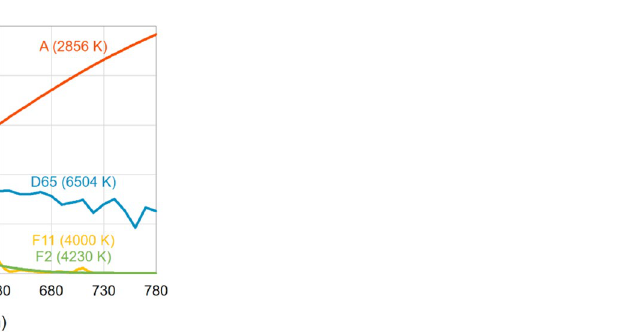
Figure 3. Relative spectral power distributions of the CIE standard illuminants used in the experiment: A (2856 K), F11 (= TL84; 4000 K), F2 (= CWF; 4230 K), and D65 (6504